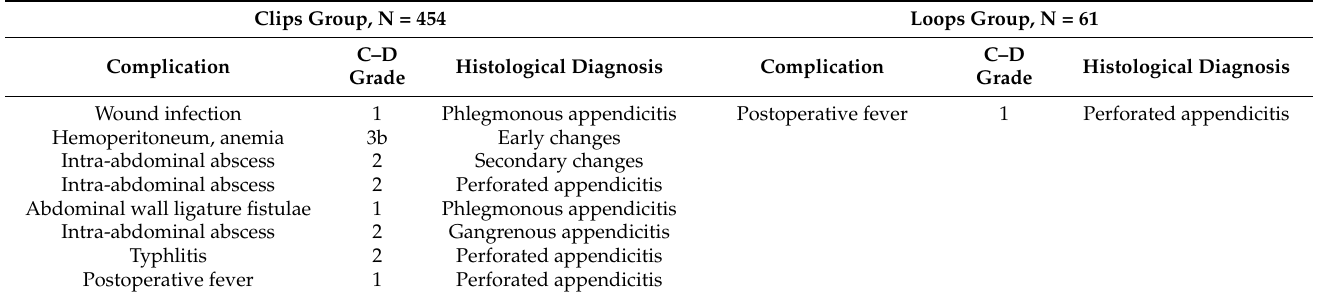
Table 4. Complications of the patients in the groups. C–D grade—complication grade according to Clavien–Dindo classification.